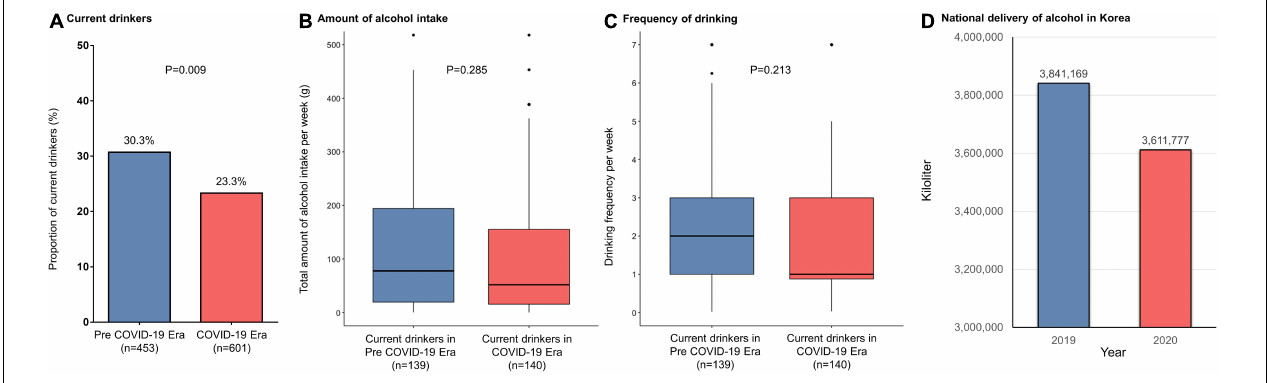
FIGURE 1 | (A) Proportion of current drinkers, (B) total alcohol intake per week, (C) frequency of drinking per week in atrial fibrillation patients undergoing catheter ablation, and (D) amounts of national alcohol deliveries in Korea. COVID-19, coronavirus disease 2019.